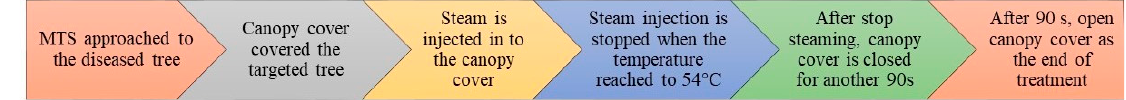
Figure 2. Heat treatment process of treating HLB-affected tree in the field [4].